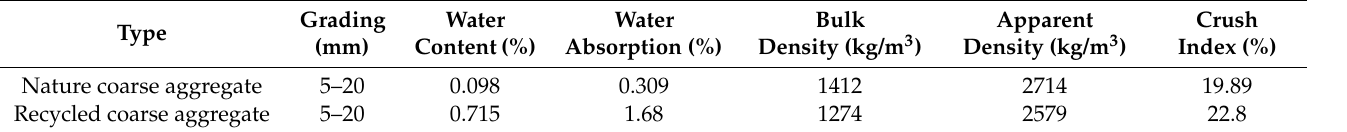
Table 1. Physical properties of the coarse aggregate.